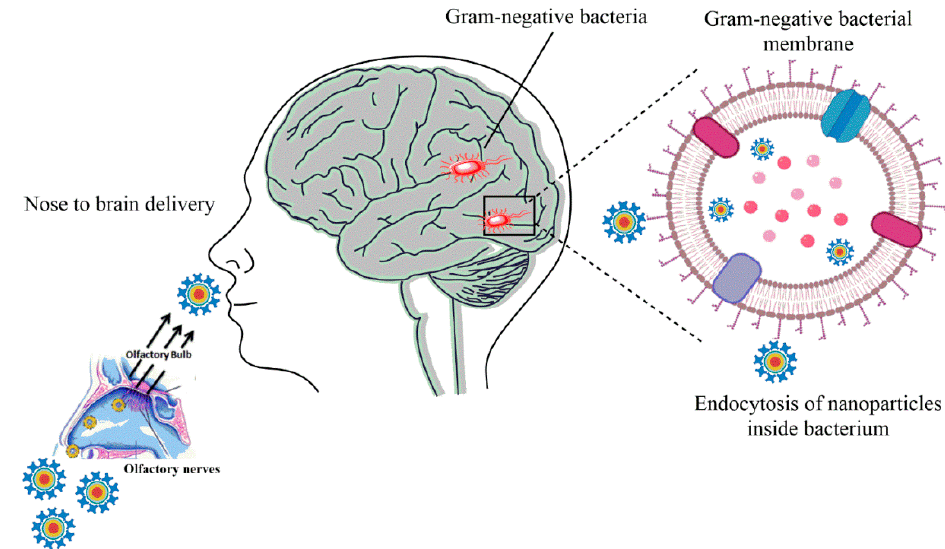
Figure 3. Nose-to-brain nanoparticle-mediated drug delivery for Gram-negative bacterial infection followed by endocytosis of nanoparticles in the bacterial cell.